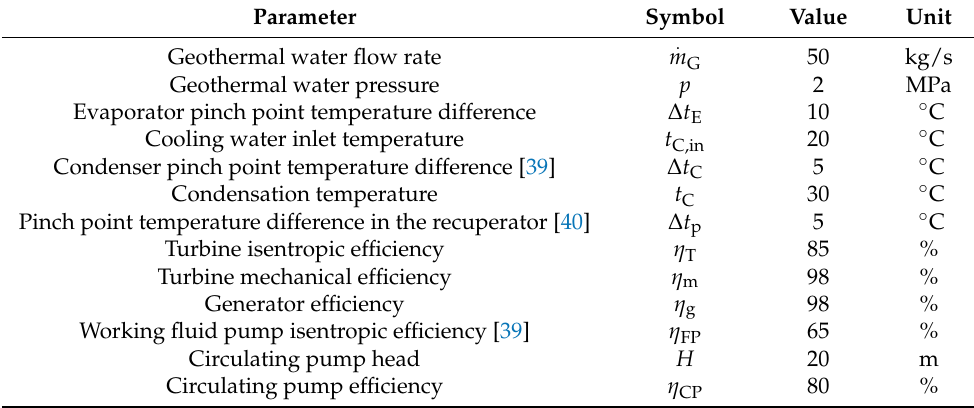
Table 2. Operating parameters and boundary conditions for the geothermal